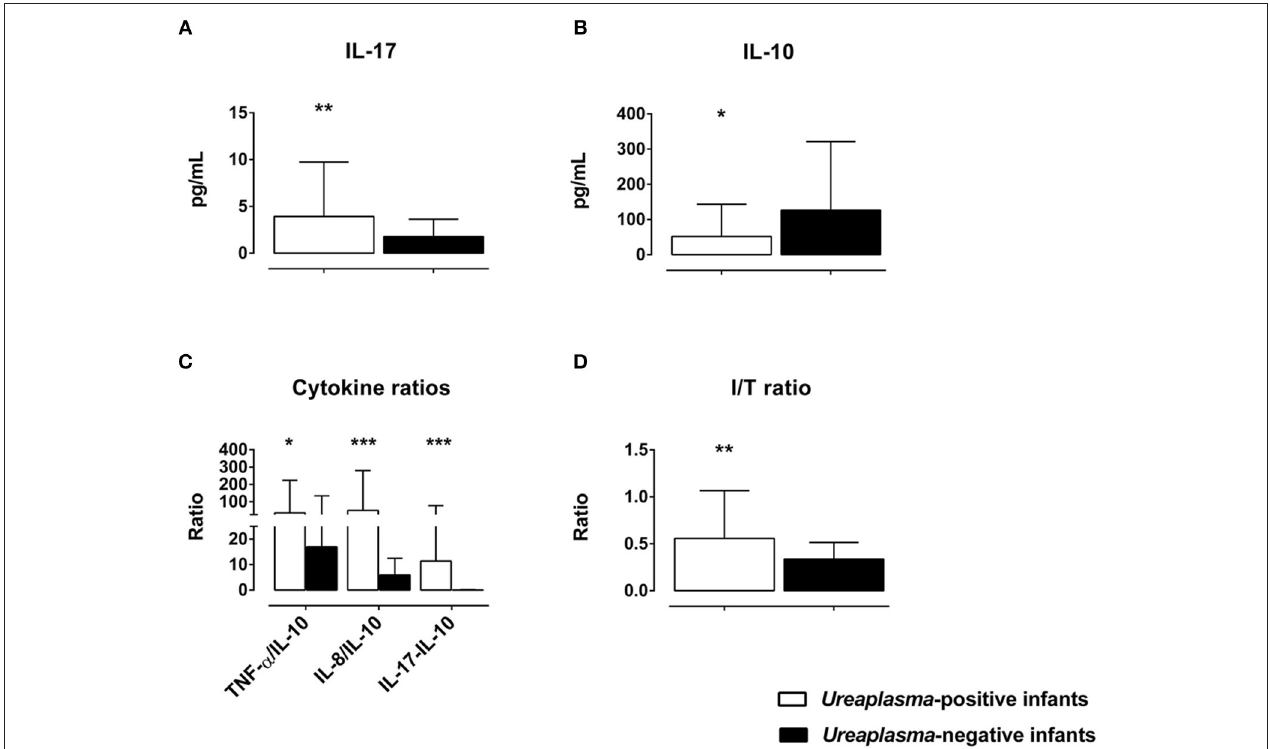
FIGURE 3 | Differences in cord blood serum levels of IL-17 (A) and IL-10 (B) , ratios of pro-inflammatory cytokines to anti-inflammatory IL-10 (C) and I/T ratios (D) among Ureaplasma -positive and Ureaplasma -negative infants on bivariate analysis (* p < 0.05, ** p < 0.01, *** p <